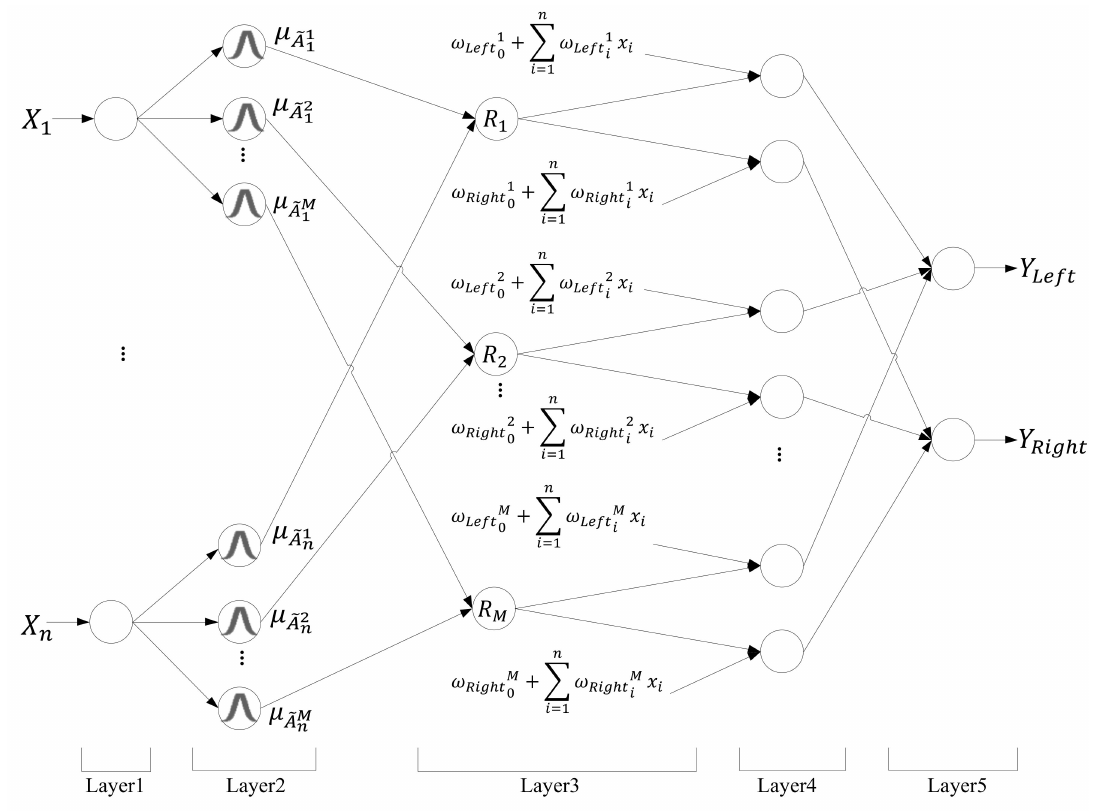
Figure 1. Structure of